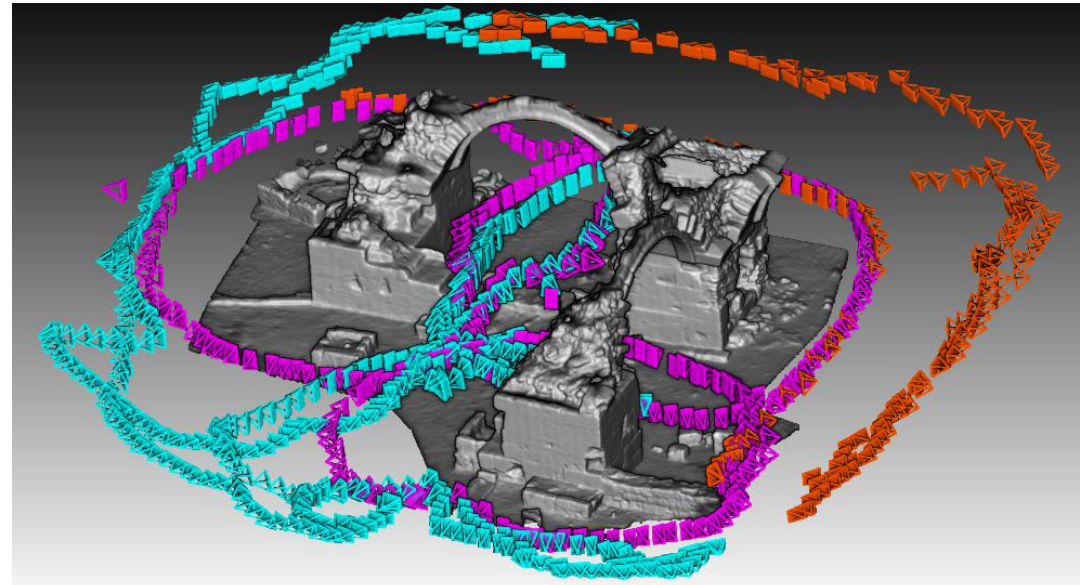
Figure 3: The shaded mesh model of the surveyed Saranta Kolones monument. The position and orientation of the extracted frames are shown as pyramids with colours indicating the three employed devices (Table 1).